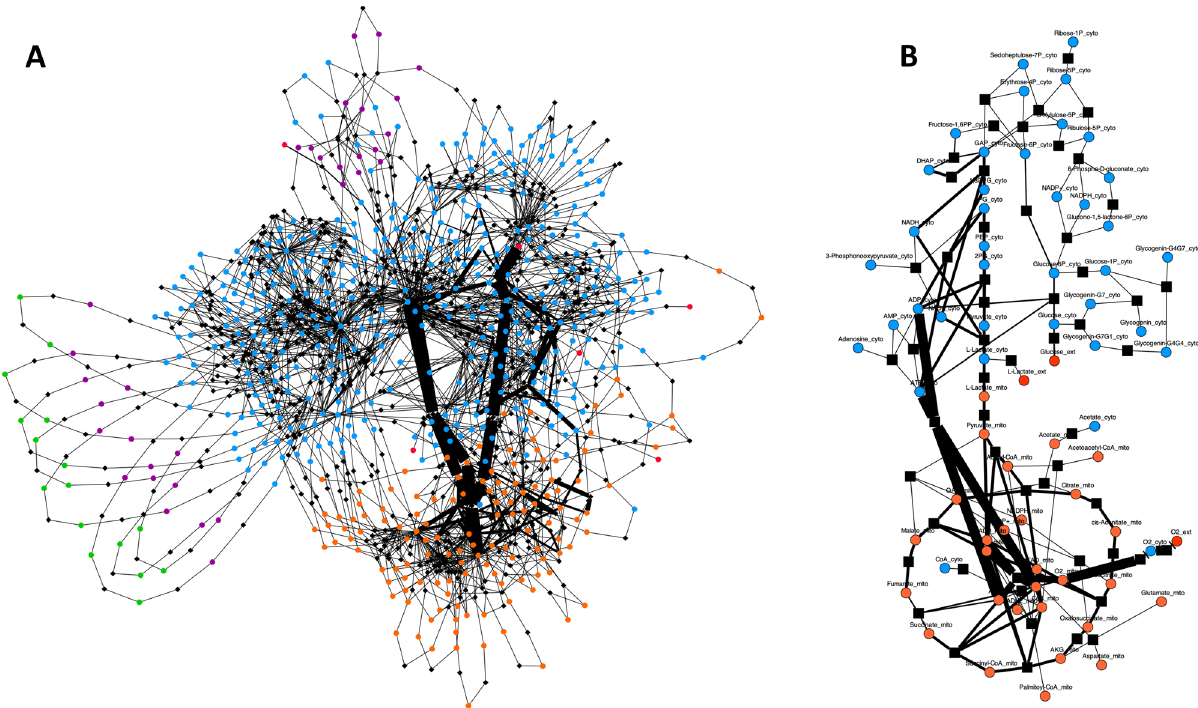
Figure 6. CardioNet in silico maternal heart metabolic flux changes in response to RUPP. Graph denotes estimated flux distribution in response to RUPP. The coloured nodes represent metabolites assigned to five different compartments: extracellular space, cytosol, mitochondria, microsome, lysosome. The black square nodes indicate reactions; two reactions are linked by a directed edge indicating the reaction flux. The